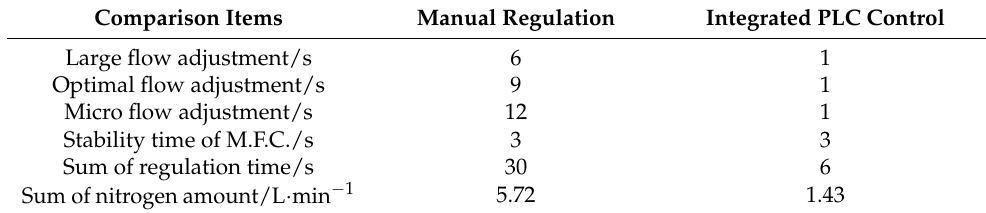
Table 3. Manual regulation vs. Integrated PLC